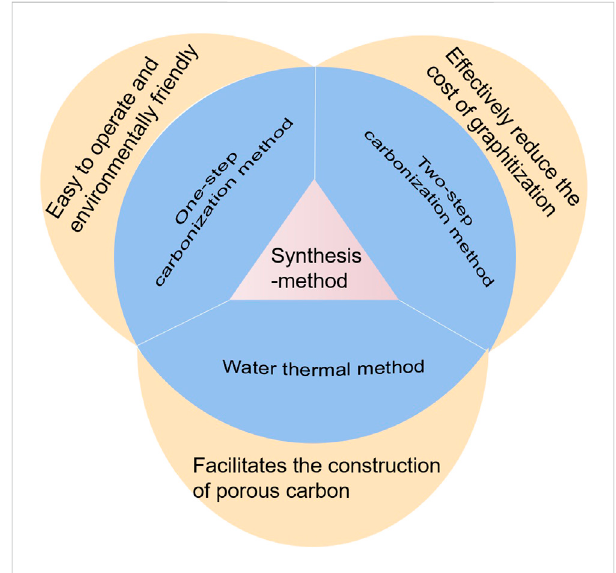
FIGURE 1 Different synthesis methods and